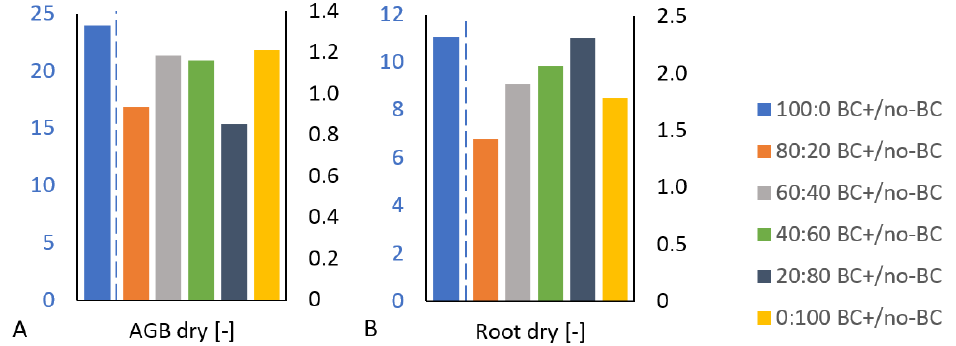
Figure 3. ( A ) Dry aboveground biomass and ( B ) dry root biomass trends, i.e., the ratio (of average values) between the plant biomass of the biochar-amended (BC+) and the plant biomass of the unamended (no-BC) treatments, sorted according to decreasing sand:soil ratios (aligned from 100:0 to 0:100). Note: The blue (left) axis belongs to the blue bar (100:0 treatment), while the black (right) axis belongs to the other bars (treatments).